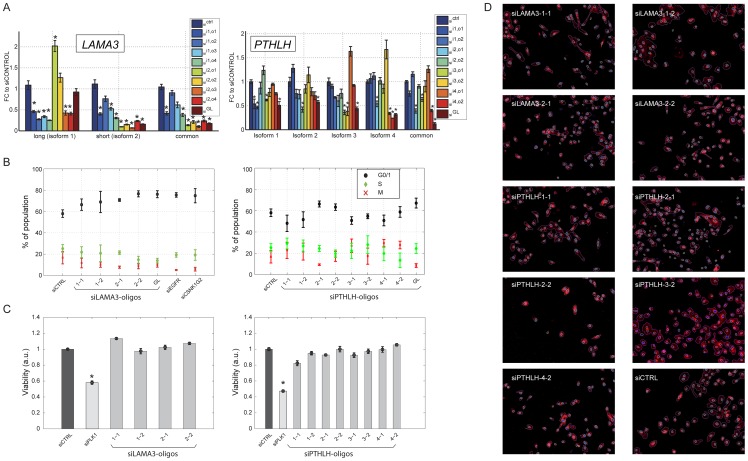
Isoform-specific knockdown and absence of significant proliferation, viability and morphological effects.(A) MCF10A cells were transfected with siRNA oligonucleotides (20 nM) targeting individual isoforms of LAMA3 (left panel) or PTHLH (right panel), siRNA pools targeting all isoforms (‘gene-level’) or with control scrambled siRNA oligonucleotides (sictrl denotes siRNA control, ‘i1,o1’ denotes the first oligonucleotide targeting isoform 1; ‘i2,o2’ the second oligonucleotide targeting isoform 2, etc. and ‘GL’ denotes ‘gene level’). Forty-eight hours later, RNA was extracted and qPCR measurements were performed using primers specific to all expressed individual isoforms, as well as primers amplifying transcript regions common to all expressed isoforms. Measurements were normalized to results obtained with an independent siRNA control replicate. Error bars denote standard errors from three technical replicates and asterisks denote statistically significant (p<0.05) differences relative to siCtrl. Similar results were obtained in three independent repeat experiments. (B) Oligonucleotides for EGFR, which impair migration, and for CSNK1G2, which accelerate migration are shown as additional controls. Cell cycle analysis was performed as described in Methods. Error bars represent the standard errors from the analysis of 24 images taken per from each of four wells per condition. (C) Viability was measured by tetrazolium-based WST-1 assay. MCF10A cells were transfected with the indicated oligonucleotides (siRNA to polo-like kinase, PLK1, served as positive control). Error bars represent standard errors from 3 biological replicates. The experiment was performed thrice. (D) Shown are morphologic effects of isoform-specific oligonucleotides targeting LAMA3 or PTHLH. Nine thousand MCF10A cells per well were transfected, starved and stimulated as described for the proliferation assays, followed by DAPI and phalloidin staining, 14 hours after stimulation. Automated image analysis was used to systematically assess changes in cell size and shape by analyzing 24 images taken per condition. No difference between the individual knockdowns was apparent (see also Figure S6B); one representative image for each condition is shown.